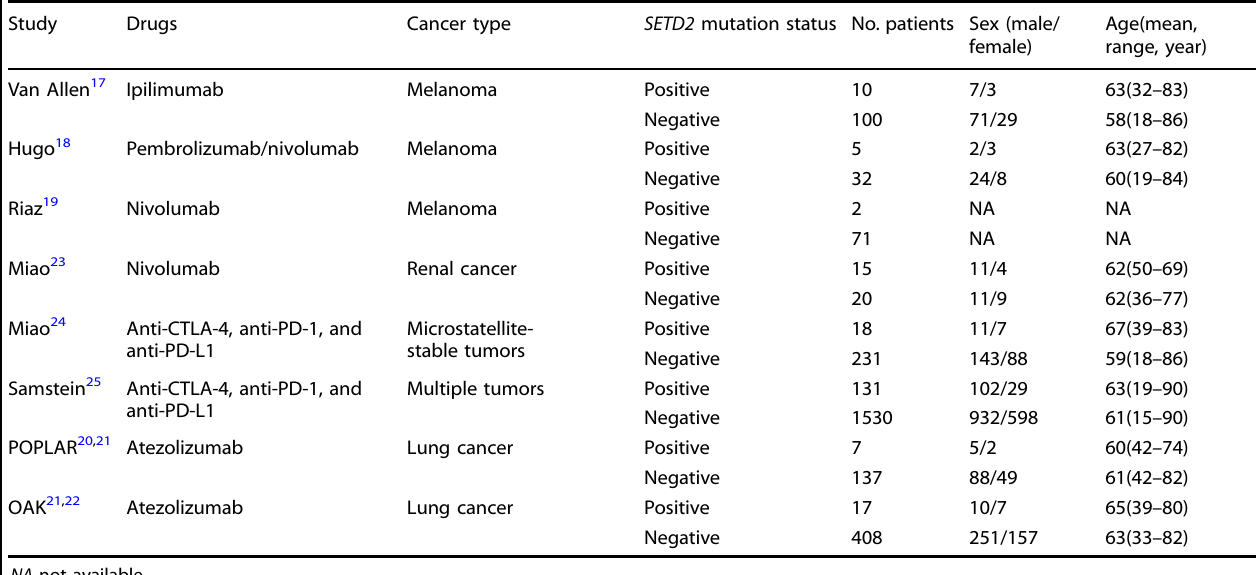
Table 1. Baseline features of 8 eligible studies included in the immunotherapy